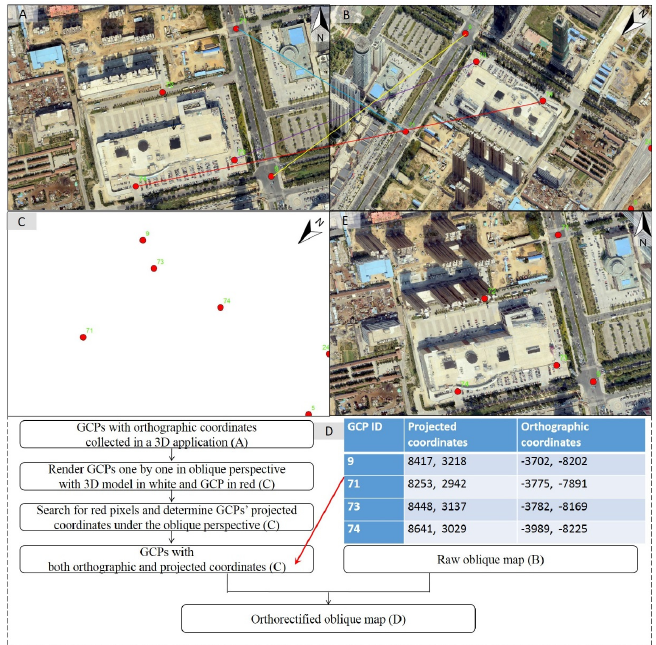
Figure 7. Illustration of the automatic GCP coordinates retrieval approach: ( A ) GCPs in an orthographic view; ( B ) GCPs in an oblique view; ( C ) GCPs rendered in an oblique view without background for identifying coordinates; ( D ) GCP table obtained for use in orthorectification; ( E ) oblique image orthorectified using the set of GCPs.